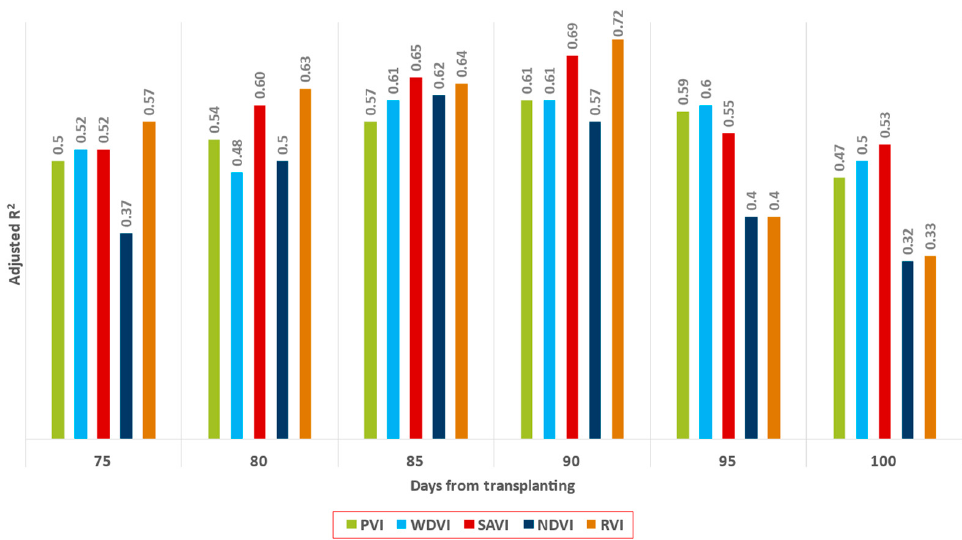
Figure 9. R 2 progress along the growth period for each of the VIs.